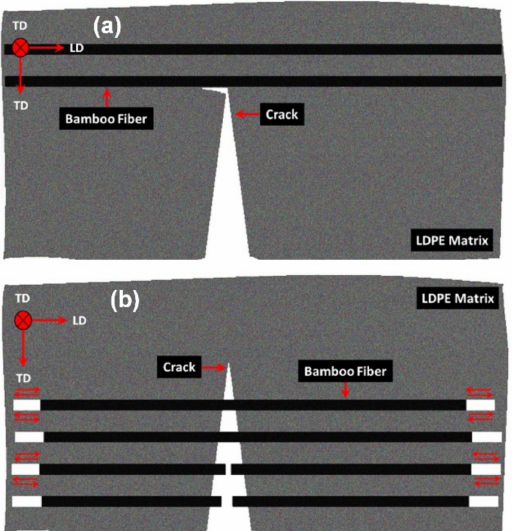
Figure 7. Schematic representation of crack ( a ) bridging and ( b ) deflection mechanisms triggered by the presence of long BFs in the LDPE-BFs composite